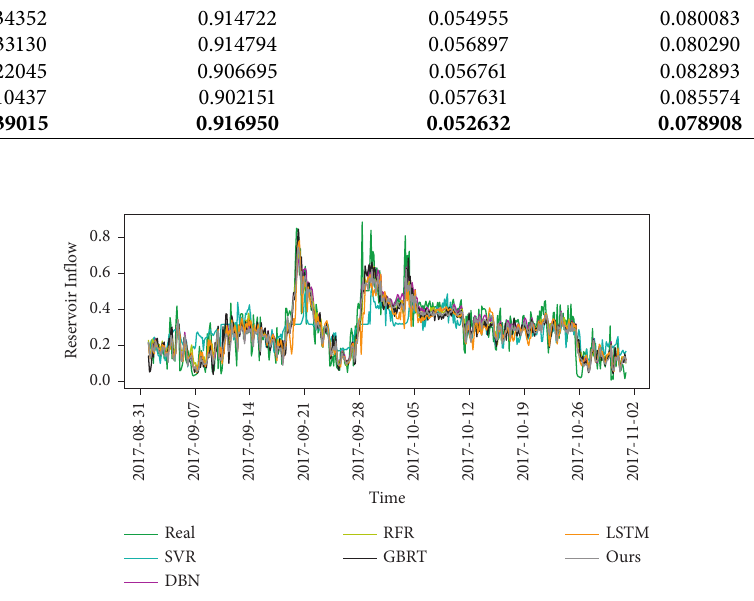
Figure 9: The predicted results over testing period for 3h lead times.